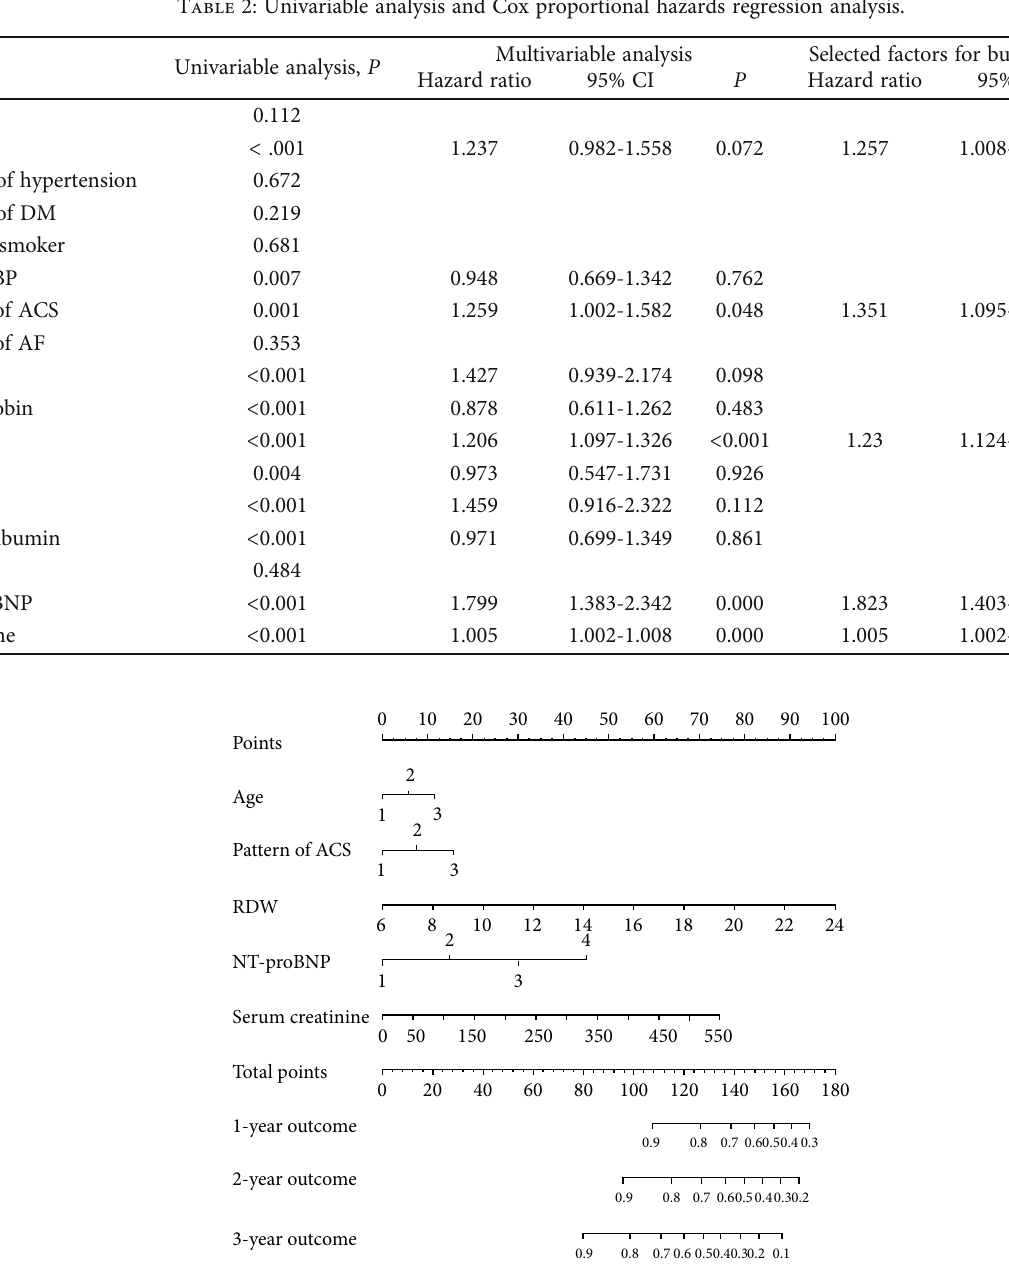
Figure 1: Establishment of a nomogram risk model for prediction all-cause mortality in patients with atrial fi brillation and acute coronary syndrome who underwent percutaneous coronary intervention. To use the nomogram, an individual patient ’ s value is located on each variable axis, and a line is drawn upward to determine the number of points received for each variable value. The sum of these numbers is located on the Total Points axis, and a line is drawn downward to the survival axes to determine the likelihood of 1-, 2-, or 3-year